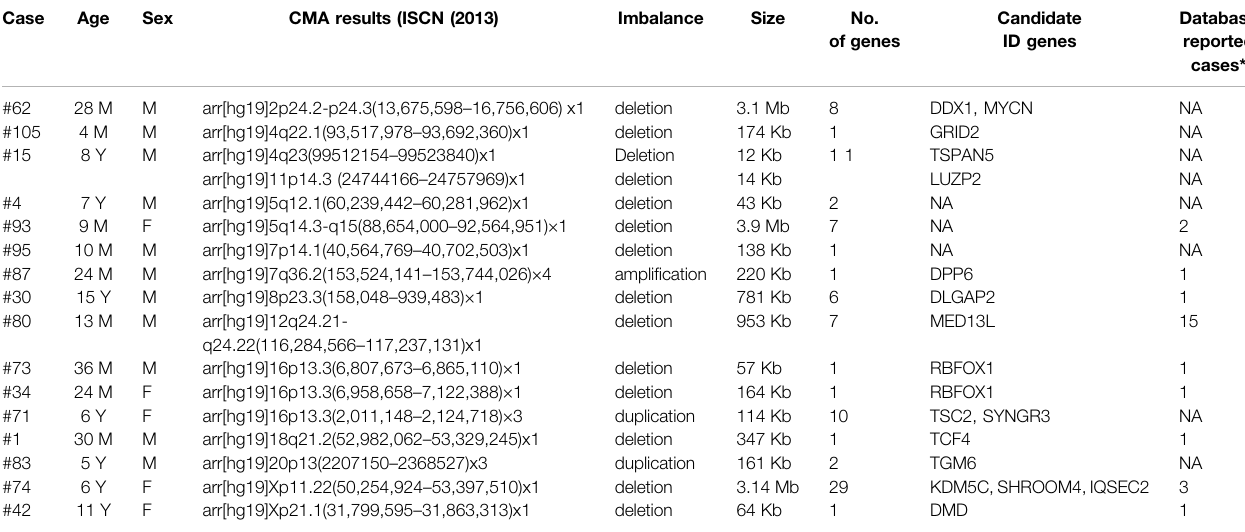
TABLE 2 | Genomic CNVs of uncertain clinical signi fi cance identi fi ed by CMA in 21 patients with ID.